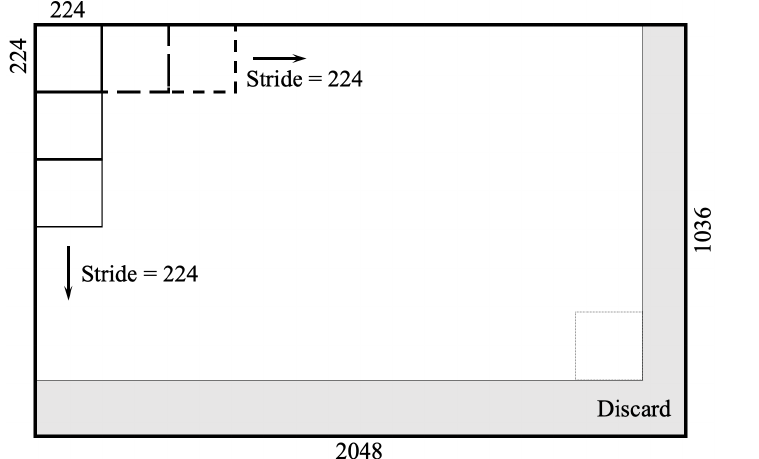
Figure 7. The schematic of cropping.